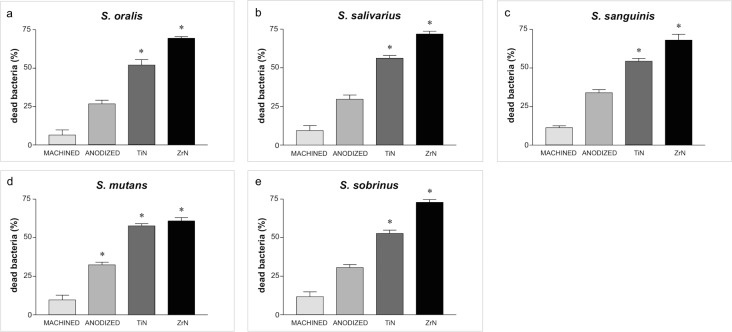
Percentage of dead bacteria.Percentage of dead bacteria in five strains grown on disks after 120 hours of incubation: a) S. oralis; b) S. salivarius; c) S. sanguinis; d) S. mutans; e) S. sobrinus.